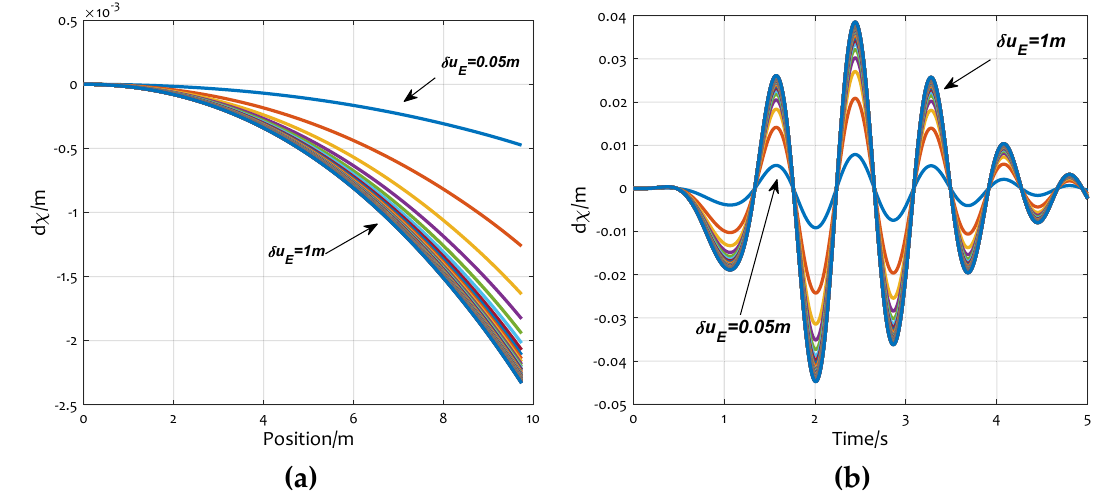
Figure 10. The impact of random field correlation: ( a ) the change of d χ at 1.3 s by different δ u ; ( b ) d χ response at different time by different δ u .